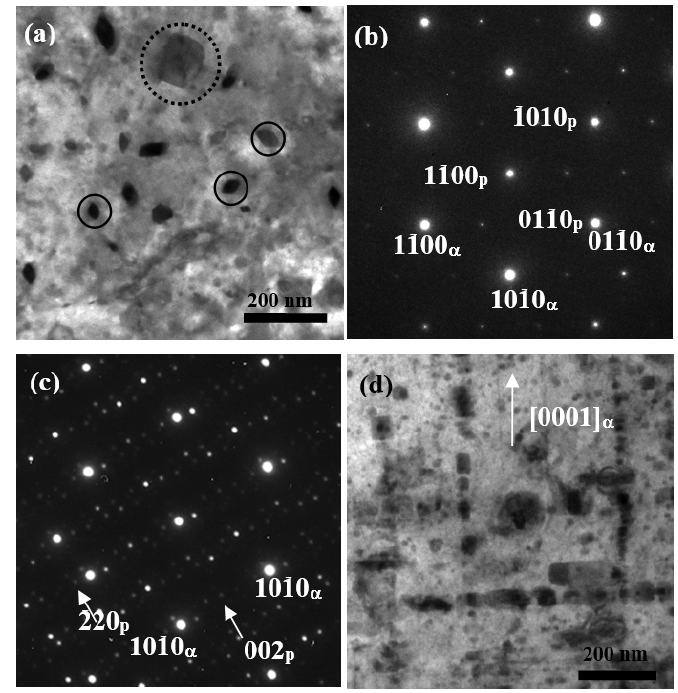
Figure 5. TEM micrographs showing the morphology and SAED patterns of the precipitates in the peak-aged TZA442 alloy. ( a ) Bright-field image showing the precipitate microstructure along the [0 0 0 1] α zone axis; ( b ) superimposed diffraction patterns of the rhombic precipitates and the matrix, ‘p’ in the lower left of the index indicates the MgZn 2 precipitate; ( c ) superimposed diffraction patterns of the plate precipitates and the matrix, with the extra spots from double diffractions, ‘p’ in the lower left of the index indicates theMg 2 Sn precipitate; ( d ) bright-field image showing the precipitate microstructure along a <1 1 0 0> α zone axis.